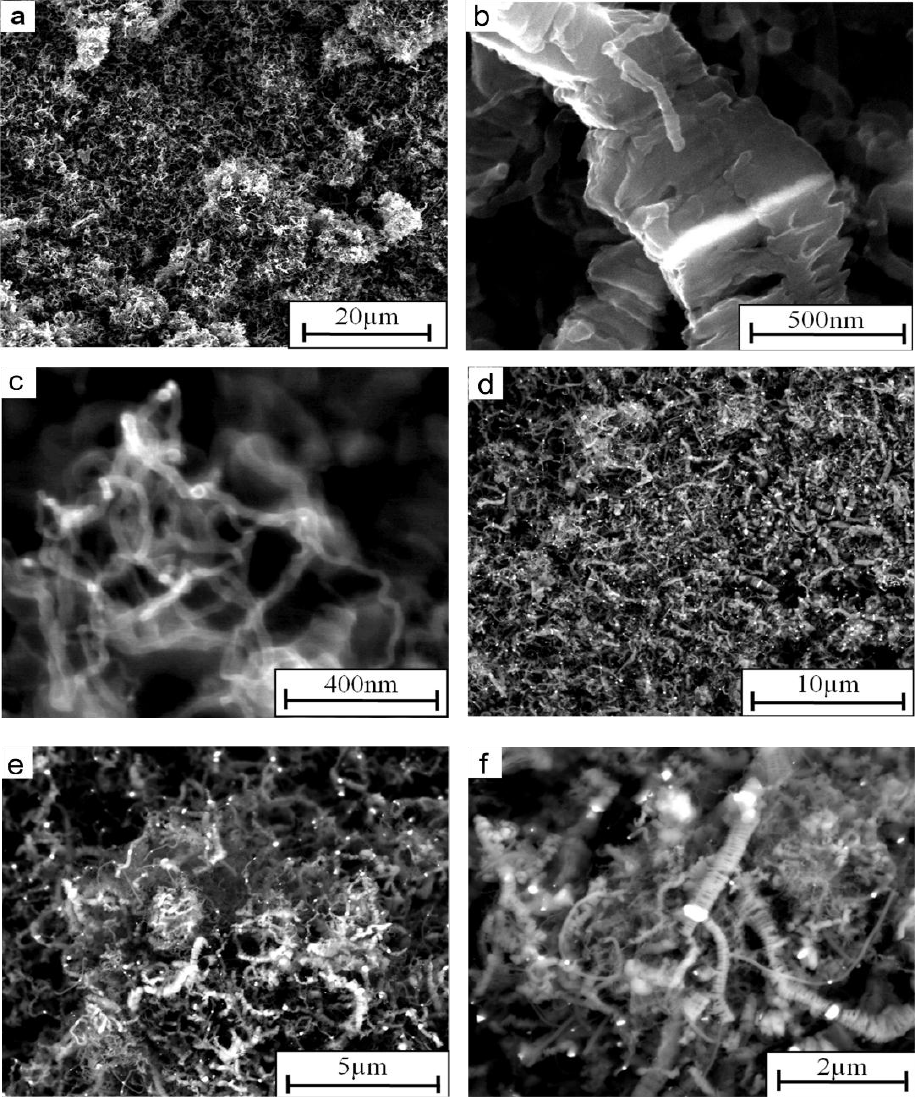
Figure 4. SEM morphology of CNFs deposited on the surface of Ni 3 Al foil after decomposition of cyclohexane at 700 °C, obtained by using ( a – c ) SE and ( d – f ) BSE